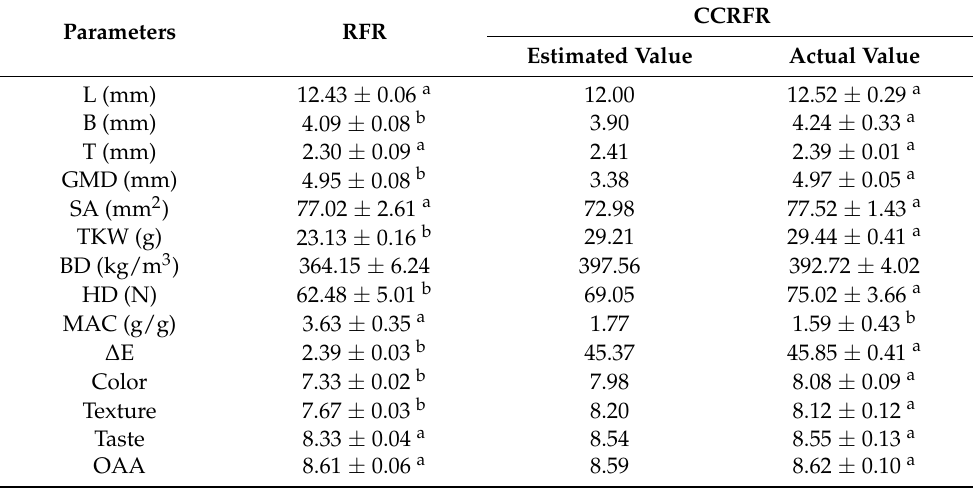
Table 4. Comparative physical, textural, functional, optical, and sensory properties of RFR and CCRFR.